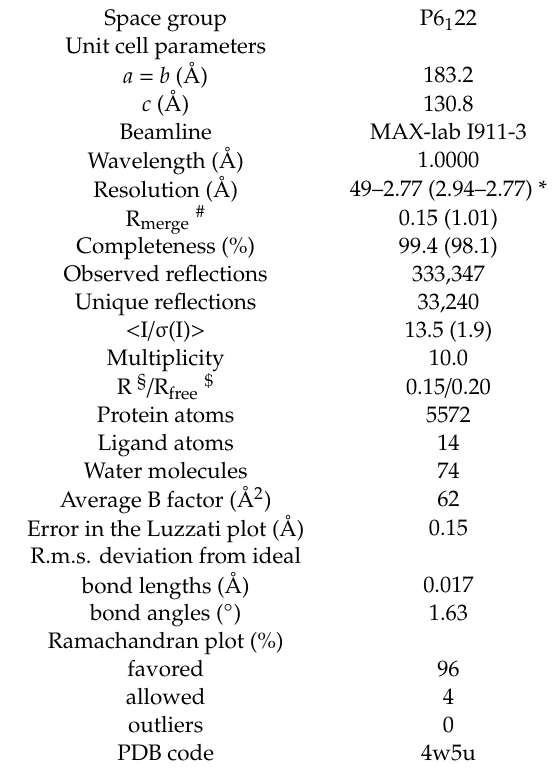
Table 2. Summary of X-ray data collection and